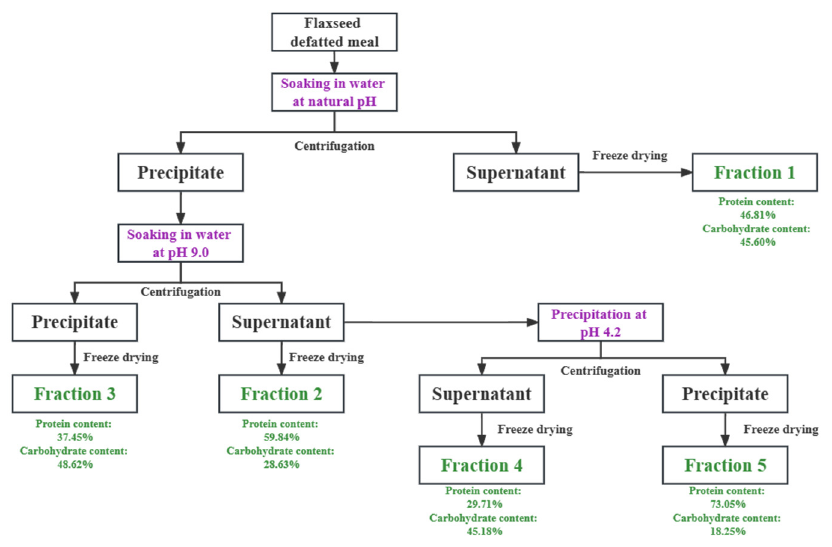
Figure 1. Schematic overview of the sequence aqueous extraction method for defatted flaxseed meal.